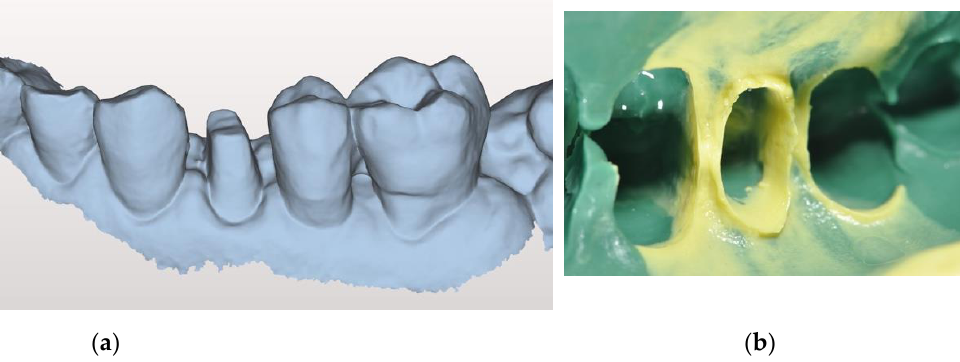
Figure 3. Digital impression ( a )Analogic impression. The deep preparation is evident ( b